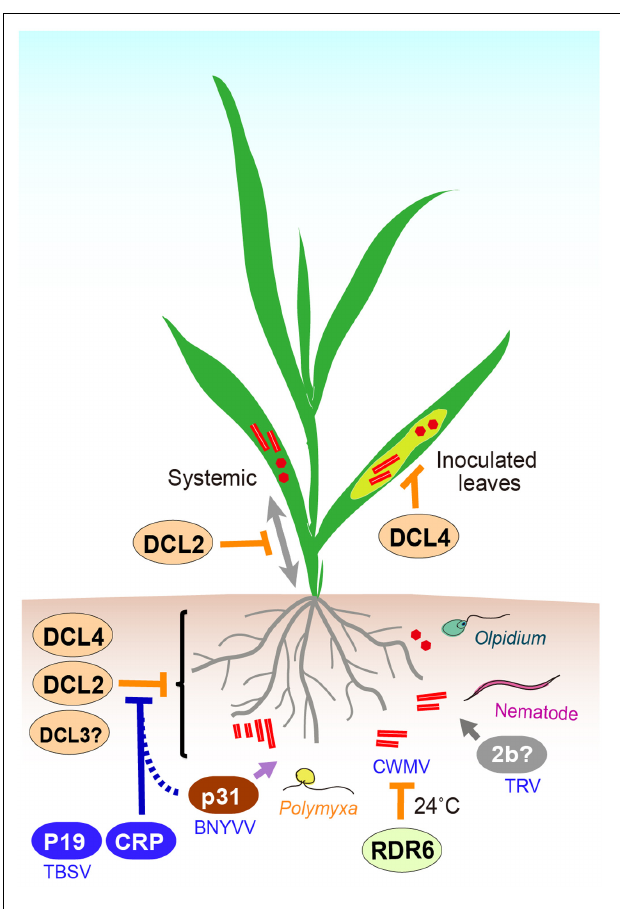
FIGURE 2 | A cartoon presentation illustrating the interplay between viruses and antiviral RNA silencing in roots. In Arabidopsis thaliana , DCL4 is essential for the inhibition of PVX accumulation in inoculated leaves, while DCL2 particularly functions in blocking of PVX systemic infection. DCL4 is the primary DCL protein component involved in intracellular antiviral silencing in roots, but it can be functionally compensated for by DCL2 or possibly partially, DCL3. At higher temperatures (after a temperature shift to 24 ◦ C, see main text), RDR6 is involved in inhibition of CWMV multiplication in Nicotiana benthamiana , whereas at the same temperature other mechanism(s) is mainly responsible for CWMV inhibition in shoots. Cysteine rich proteins (CRPs) encoded by TRV and BNYVV more effectively suppress RNA silencing in roots than in leaves. BNYVV p31 exhibits root-specific RNA silencing suppression activity and contributes to efficient virus transmission by Polymyxa betae vector into roots. TBSV P19 expression is essential for TBSV infection via root mechanical inoculation in N. benthamiana